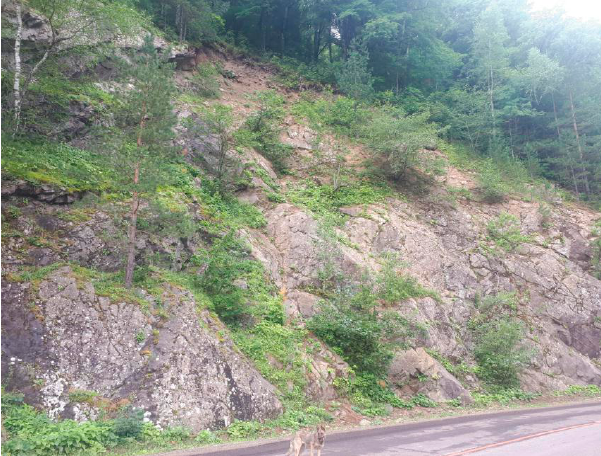
Figure 4. A typical crystalline rock exposure along the road in the Granite Gorge. Dog stays for scale.